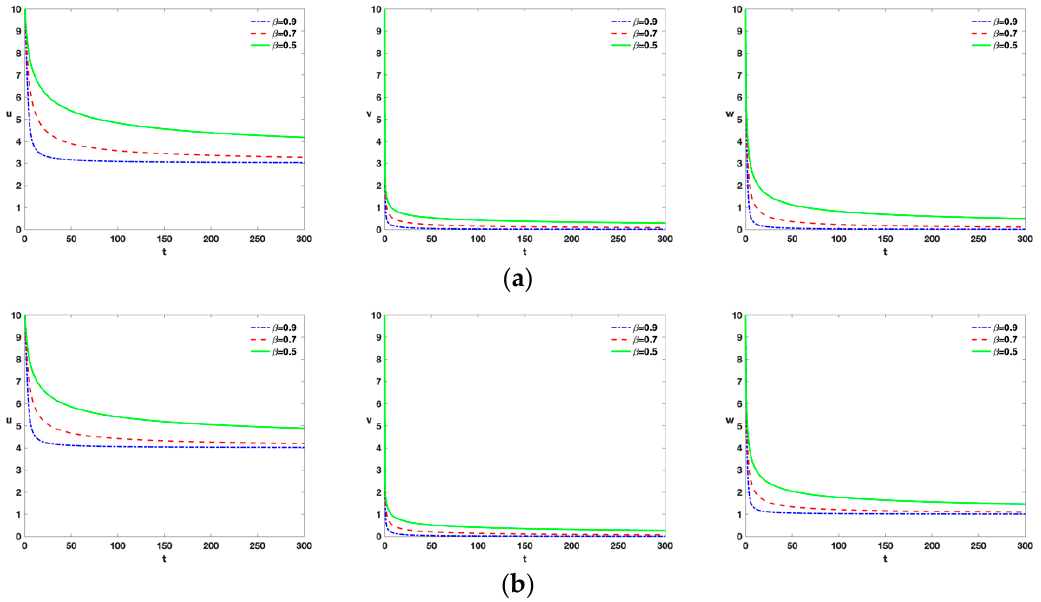
Figure 3. Time series of model (Equation (1)) with a = 0.9, m